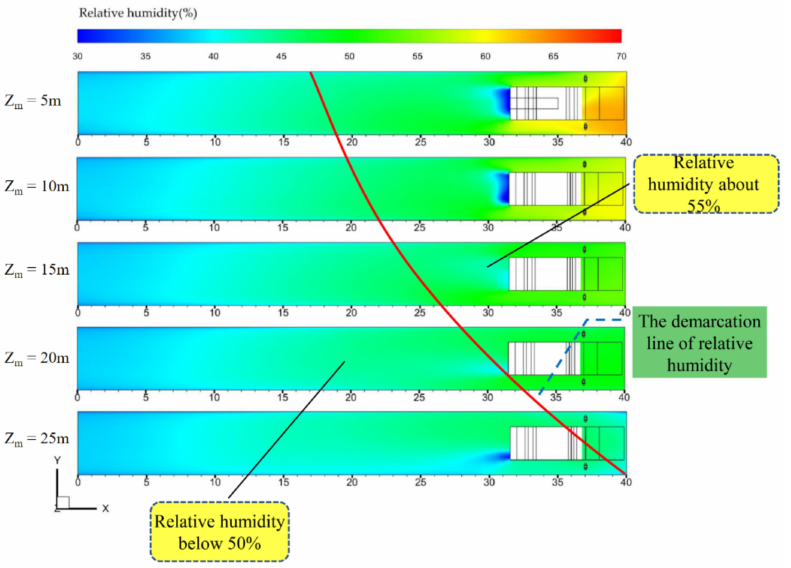
Figure 10. Relative humidity distributions of the airflow on Plane A for different Z m